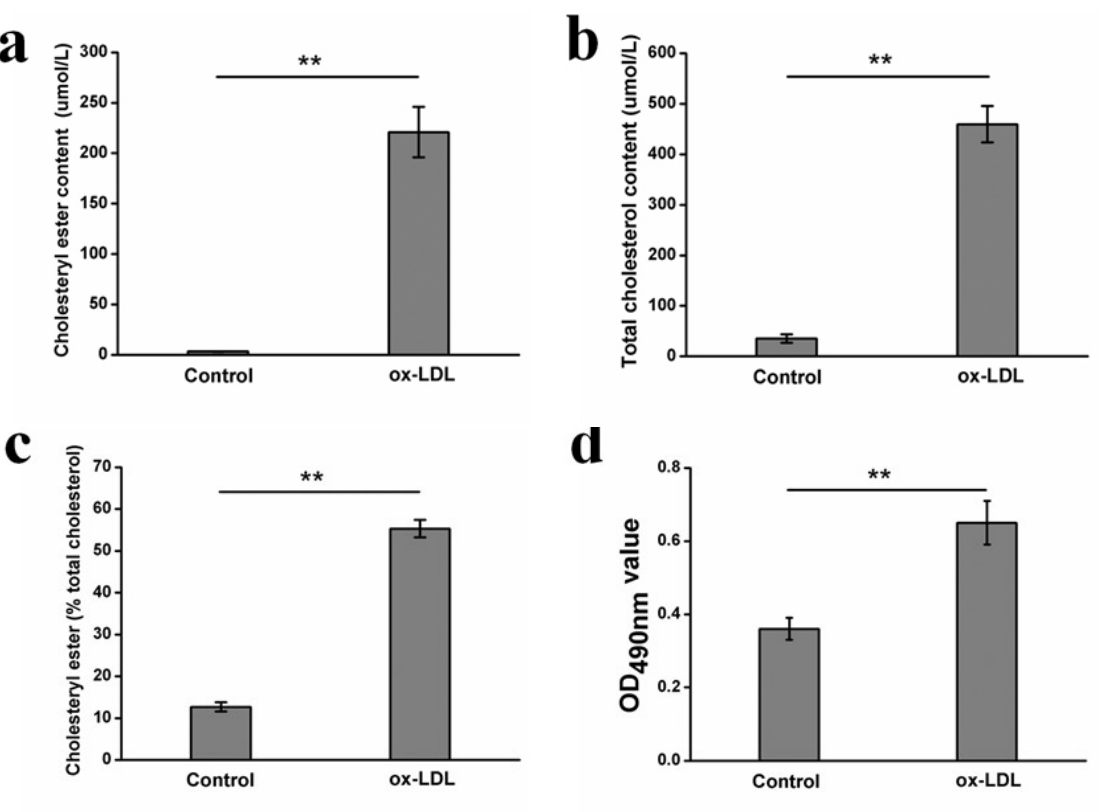
Fig. 2 - Effects of ox-LDL on HASMC. a: cholesterol ester content; b: total cholesterol content; c: ratio of cholesterol ester to total cholesterol; d: